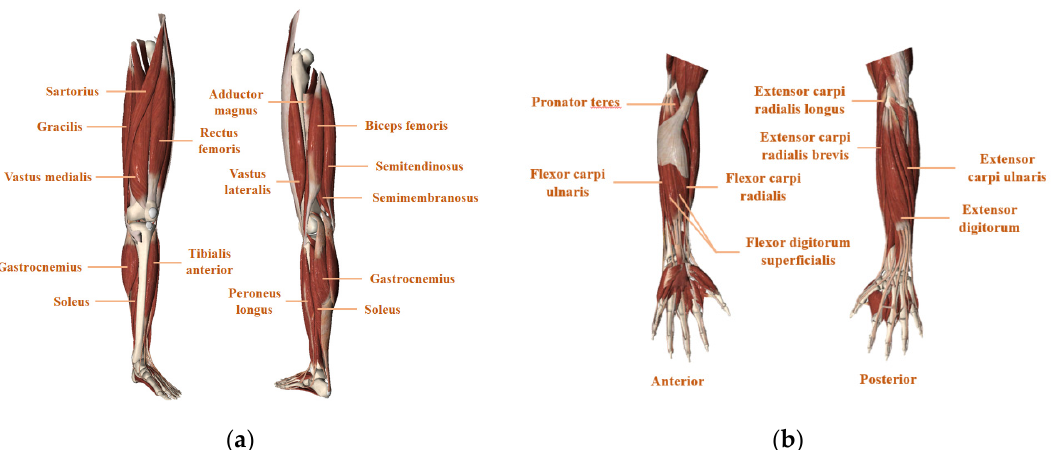
Figure 6. Longitudinal representation of the muscle groups of ( a ) the lower limb (shank and thigh). ( b ) the upper limb (elbow and hand). Table 1. Summary of the selected muscle group for detecting electromyography (EMG) signals.